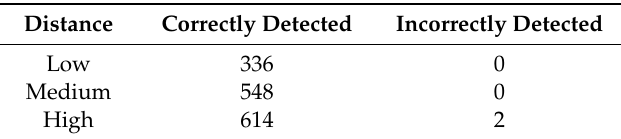
Table 1. Results of shoreline detection.